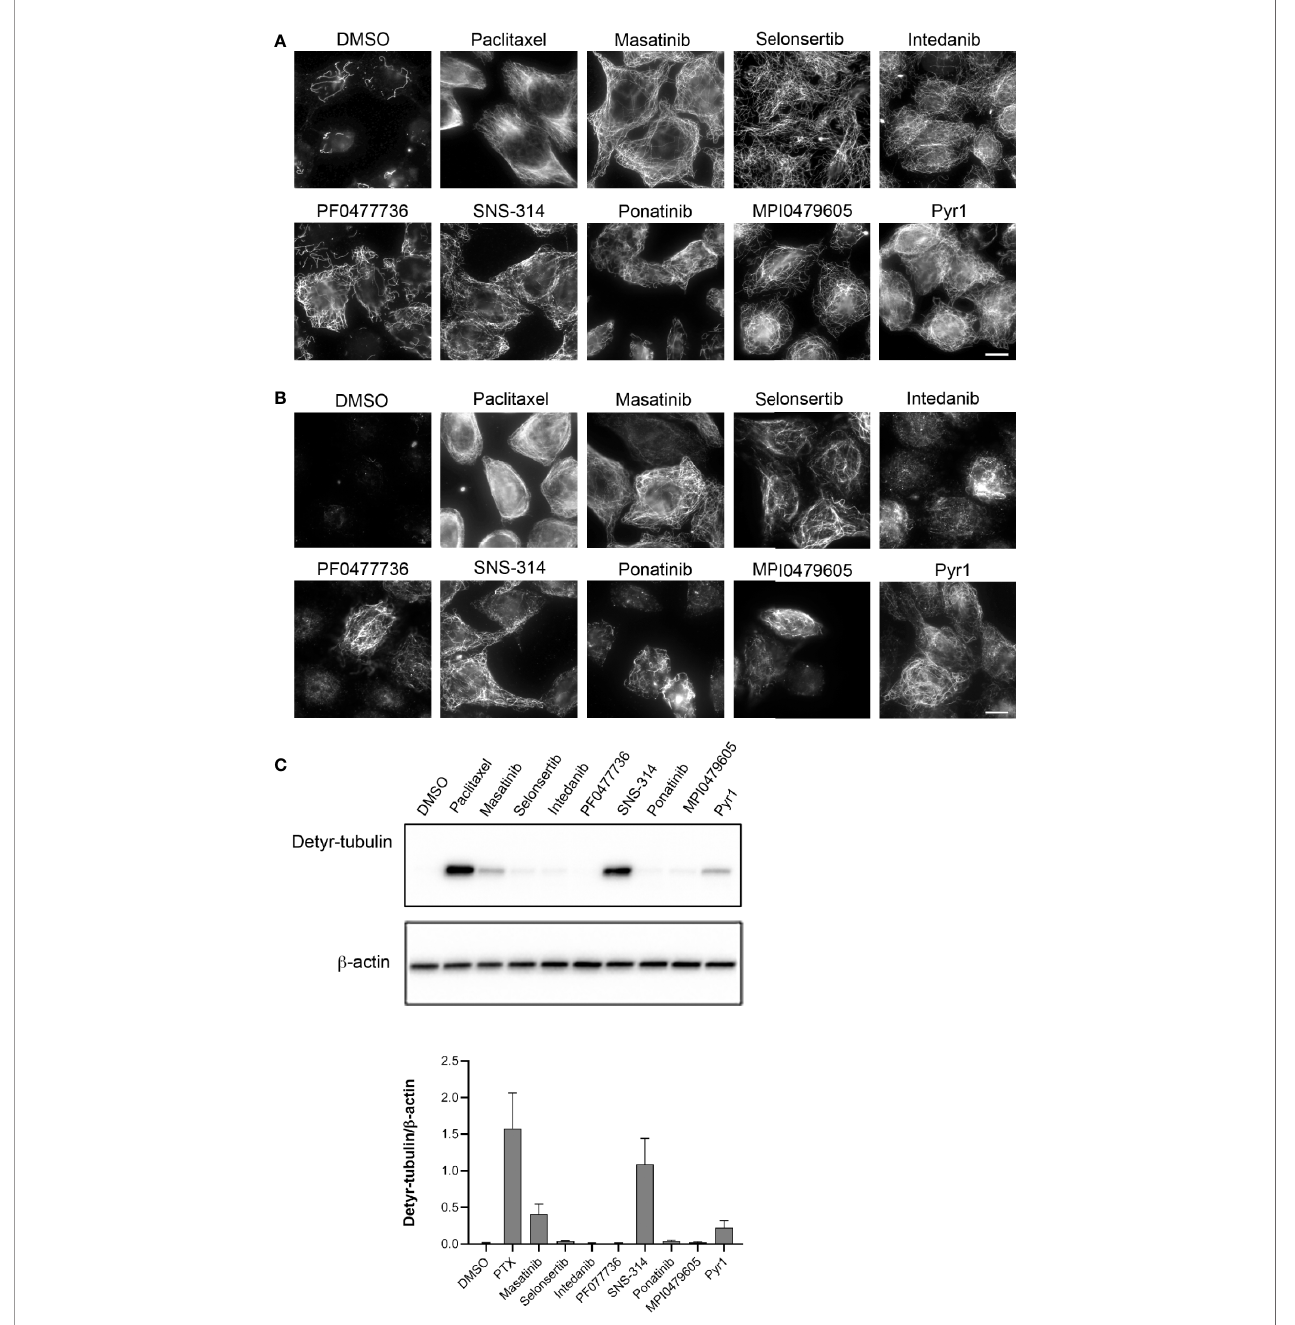
FIGURE 3 | Con fi rmation of potent microtubule stabilization after treatment of cells with the selected protein kinase inhibitors. (A) Kinase inhibitors protect MTs from CA4-induced depolymerization. HeLa cells were incubated for 90 min with 0.25% DMSO, 10 µM paclitaxel, or 10 µM of the indicated kinase inhibitors. CA4 (0.5 µM) was then added for 30 min. Cells were permeabilized and processed for immuno fl uorescence using an anti- a -tubulin antibody. Scale bar, 10 µm. (B) Treatment with the kinase inhibitors increases the detyrosinated MT content of cells. HeLa cells were treated for 2 h with 0.25% DMSO, 10 µM paclitaxel, or 20 µM of the indicated kinase inhibitors. Cells were then permeabilized and processed for immuno fl uorescence, using an antibody against detyrosinated tubulin. Scale bar, 10 µm. (C) Western blot to quantify the effect of kinase inhibitors on the tubulin detyrosination status. HeLa cells were treated for 2 h with 0.25% DMSO, 10 µM paclitaxel, or 20 µM of the indicated kinase inhibitors. Cellular protein extracts were separated by SDS-PAGE and Western blotted to detect detyrosinated tubulin (Detyr-tubulin) and b -actin. A representative Western blot of three independent experiments is shown. The intensity of the bands was quanti fi ed using ImageJ software and the calculated ratios are shown as mean +/ − SEM on the lower